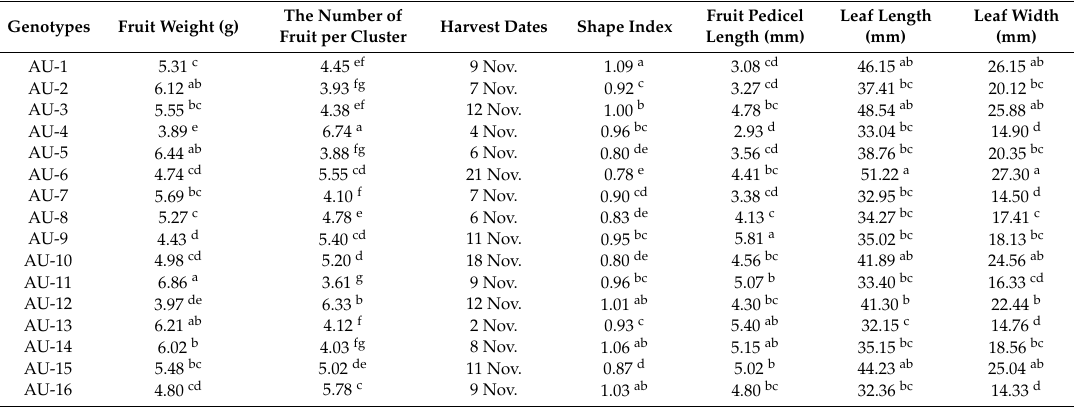
Table 1. Some phenological and morphological characteristics of fruits and leaves belong to 16 strawberry tree genotypes (average of 2017–2018 years).